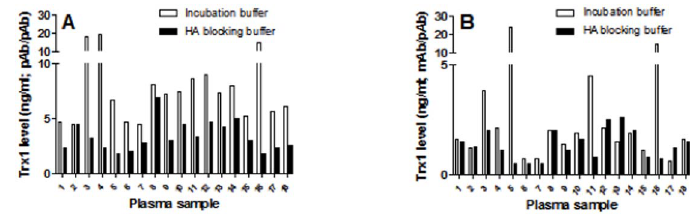
Figure 4. Analysis of the level of Trx1 in plasma samples by capture ELISA. Eighteen plasma samples from healthy blood donors were analysed for the level of Trx1 using the ELISA formats, pAb/pAb (A) and mAb/pAb (B), in the presence of either incubation buffer or a HA blocking buffer. One of two experiments with similar results is shown.